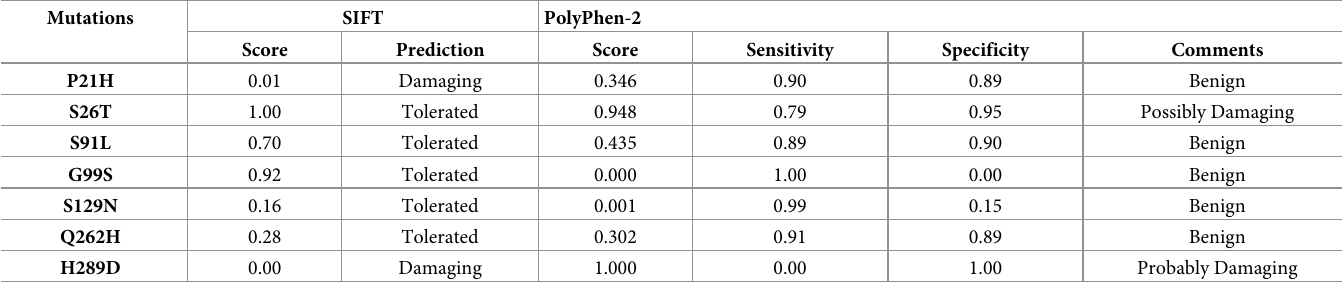
Table 5. Prediction of association between GATA1 nonsynonymous mutations and disease. Mutations